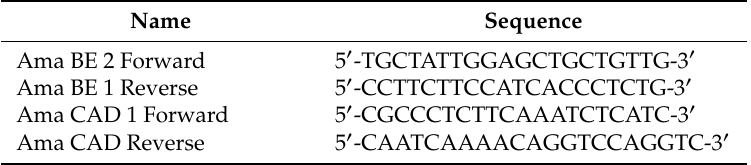
Table 1. Primers pairs (forward; reverse) used for the PCR amplification of the domains CAD and BE of the acetolactate synthase ( ALS )